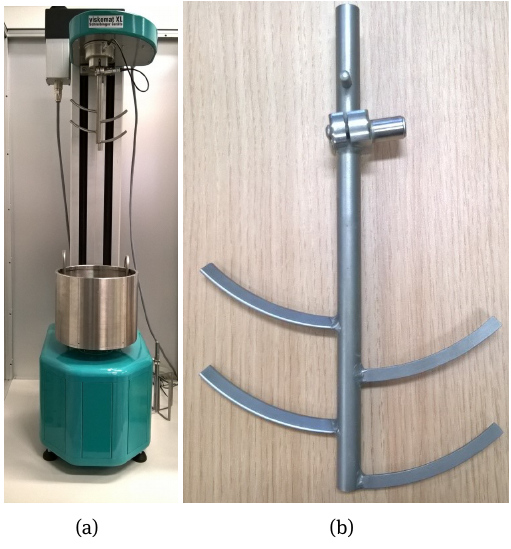
Figure 2: (a) The Viskomat XL measuring system; and (b) the im- peller used in the experimental